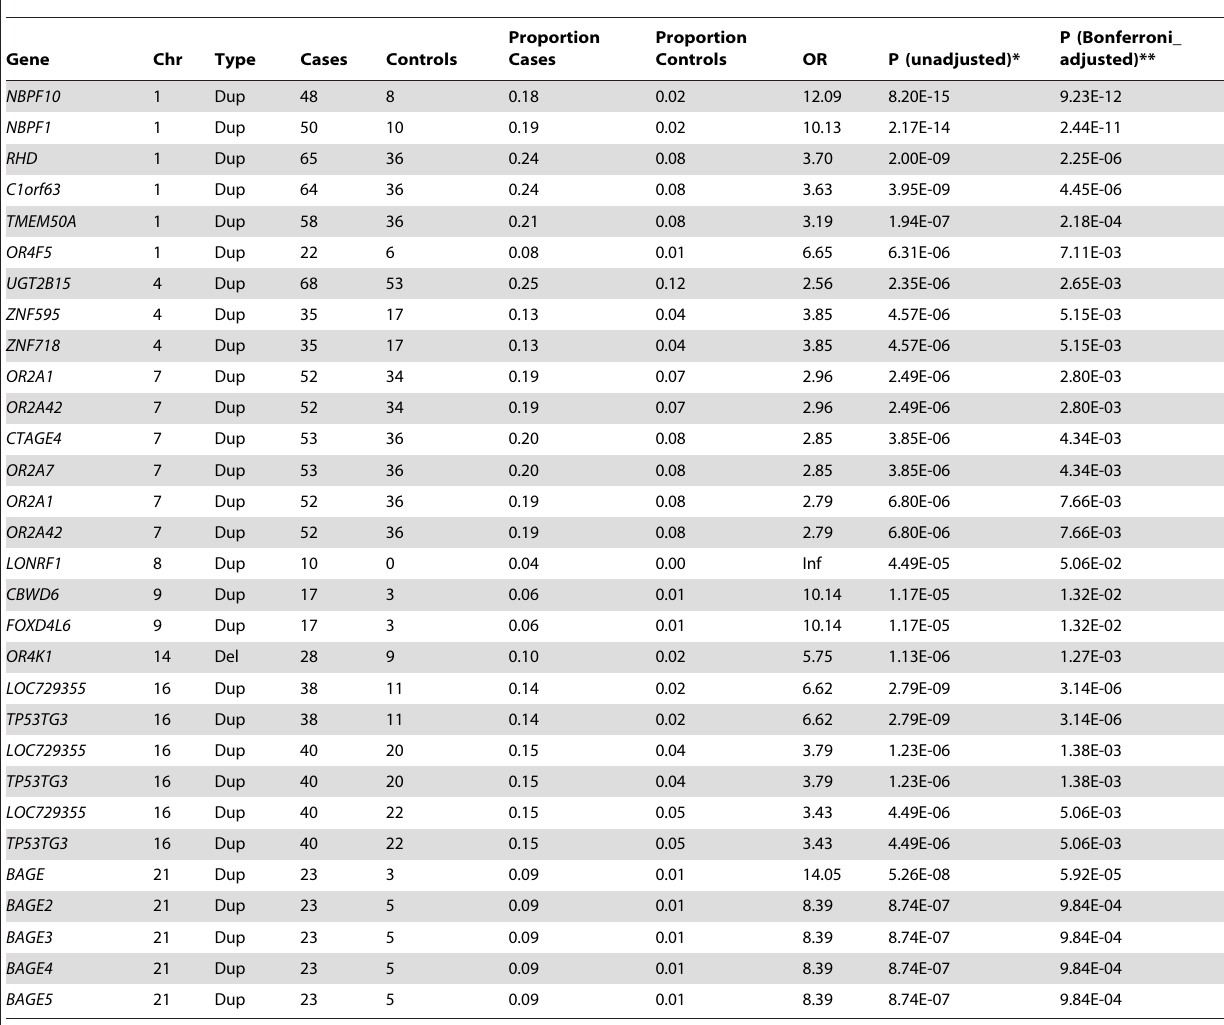
Table 3. Genes overlapping BAVM-associated CNVs